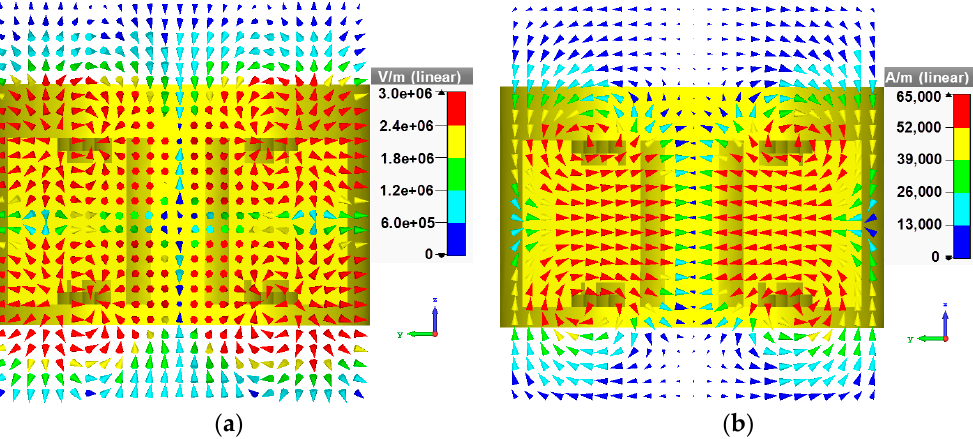
Figure 3. Electromagnetic field distribution of π + 1 mode from the longitudinal section view: ( a ) Electric field distribution, ( b ) magnetic field distribution.